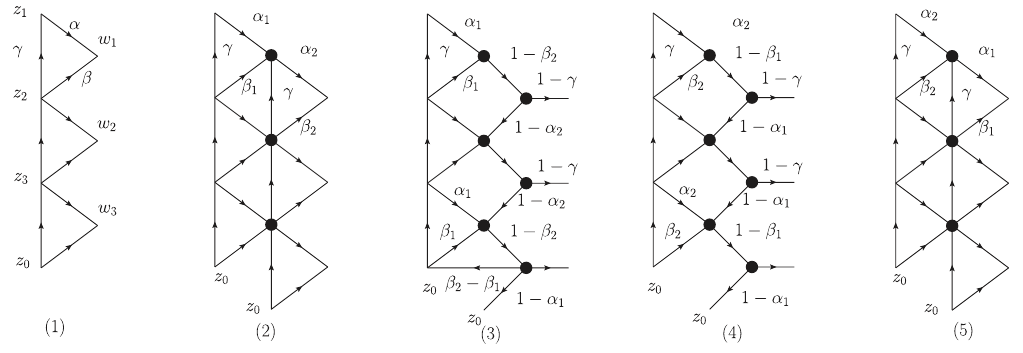
Figure 5 . The proof of commutation relation (3.6) for two operators (cid:3) N ( y for the kernel of (cid:3) 3 ( y z 0 ). (2) The diagram for (cid:3) 3 ( y 1 j (cid:12) 1 = 1 s + y 1 , (cid:12) 2 = 1 s + y 2 , (cid:13) = 2 s (cid:0) (cid:0) column of triangles, leading to (cid:3) 3 ( y 2 ) (4) Movement of the line with index (cid:12) 2